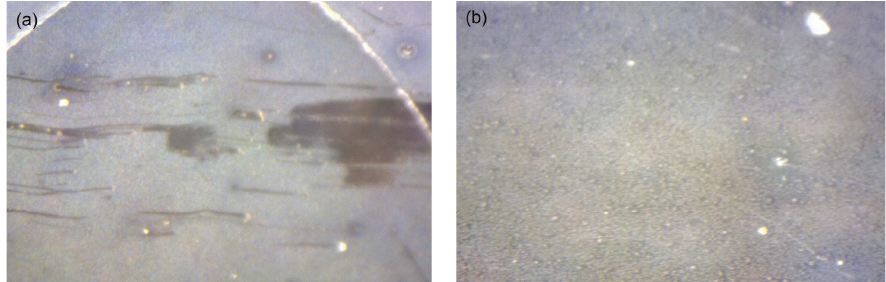
Figure 6: The 500x magnification of the coating surface from sample (a) 90N and (b) 90E.